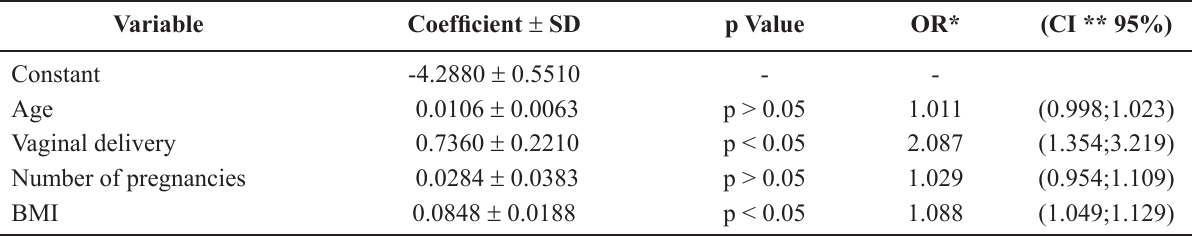
Table 3 – Model of logistic regression of urinary